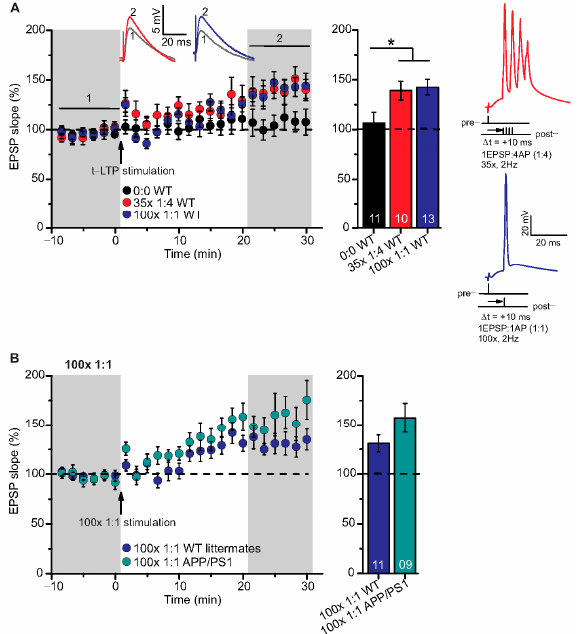
Figure 3. High repeat STDP stimulation paradigm induced t-LTP in adult wild type and APP/PS1 mice. Whole cell patch clamp recordings of t-LTP as described in Figure 2. Left: mean time course for EPSP slopes with either of the two different STDP paradigms (indicated by arrows). Right: Averaged changes in EPSP slopes 21–30 min following t-LTP induction normalized to control before t-LTP induction. ( A ) Insets: average EPSP before (1) and after t-LTP induction (2). 35 × 1:4 (red circles, n = 10/N = 10; p = 0.04) and 100 × 1:1 stimulation (blue circles, n = 13/N = 12; p = 0.02) induced significant t-LTP in WT mice in comparison to unpaired control (0:0; black circles, n = 11/N = 7). Insets: 35 × 1:4 (red color) and 100 × 1:1 (blue color) STDP paradigms at 2 Hz. ( B ) 100 × 1:1 stimulation induced comparable t-LTP in APP/PS1 mice (cyan circles, n = 9/N = 5; p = 0.126) and WT littermates (blue circles, n = 11/N = 5). Scale bars are shown in the respective insets. Data shown as mean ± SEM. Digits in the bars indicate the number of recorded neurons per condition. *: p < 0.05, multiple comparisons were performed with ANOVA followed by post hoc Dunnett’s test ( A ) and parametric data were compared with two-tailed Student’s t-test ( B